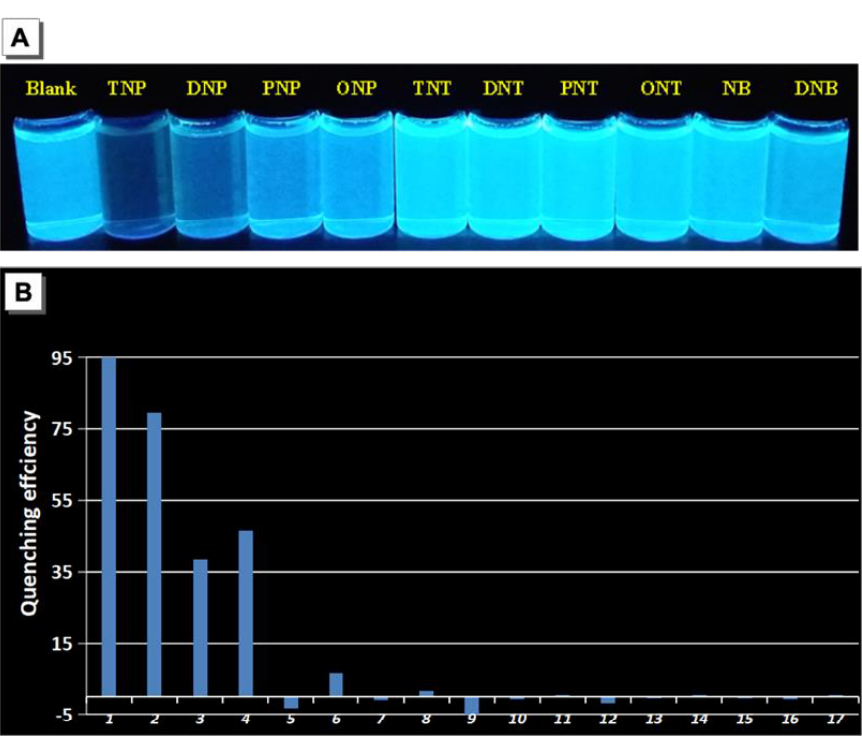
Figure 2. ( A ) Fluorescent images of compound 3 with various nitrophenolic explosives under a 365 nm UV lamp. ( B ) The Fluorescence quenching efficiencies ((1 − I / I 0 ) × 100%), where I and I 0 denote the fluorescence intensity of compound 3 with and without analytes, respectively. 1: TNP, 2: DNP, 3: PNP, 4: ONP, 5: TNT, 6: DNT, 7: PNT, 8: ONT, 9: NB, 10: DNB, 11: DNFB, 12: HPN, 13: DNCB, 14: 3 − Cyanopheno, 15: Phenol, 16: DNA, 17: HBN. Solvent: H 2 O: THF = 9: 1, [ 3 ]